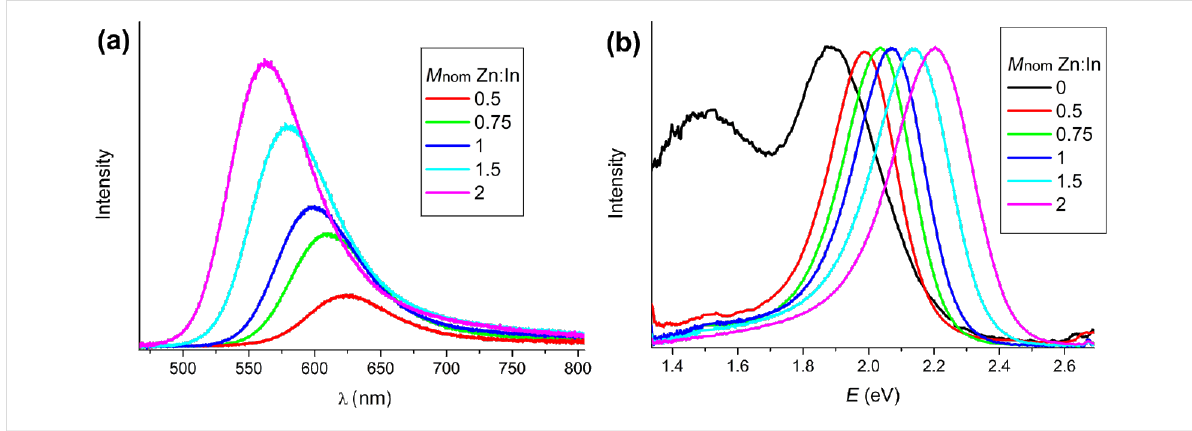
Figure 8: (a) PL spectra of synthesized QDs; (b) normalized PL spectra in energy coordinates.